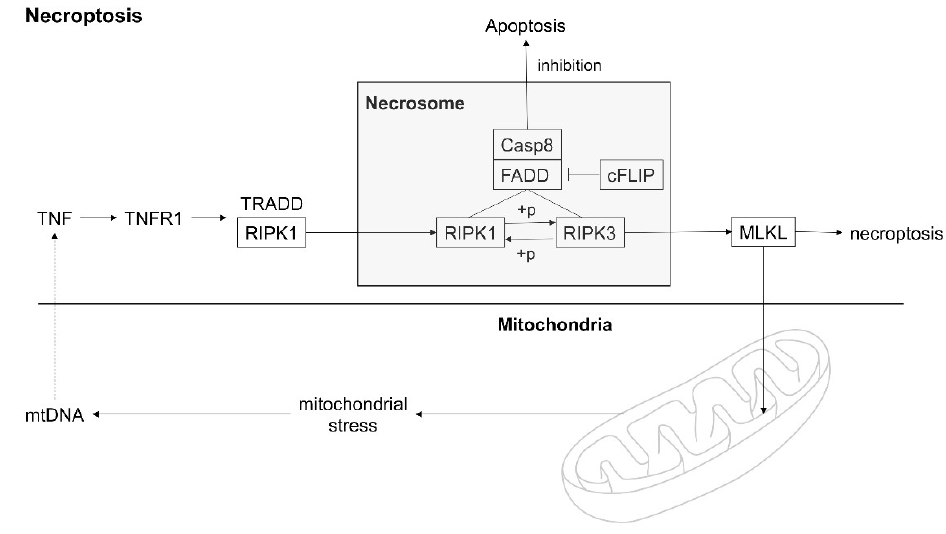
Figure 1. Schematic representation of a correlation between necroptosis and extracellular mitochondrial DNA. TNF, tumor necrosis factor; TNFR1, TNF receptor 1; TRADD, TNFR1-associated death domain; RIPK1, receptor-interacting protein kinase 1; RIPK3, receptor-interacting protein kinase 3; FADD, Fas-associated death domain; Casp8, caspase-8; cFLIP, cellular FLICE (FADD-like IL-1β-converting enzyme)-inhibitory protein; MLKL, mixed-lineage kinase domain-like; mtDNA, mitochondrial DNA.